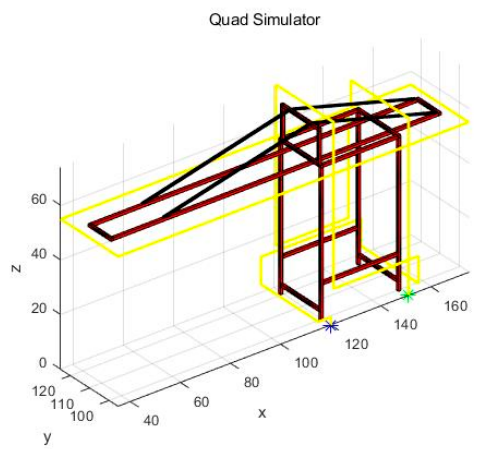
Figure 3. Simulation model of the quay crane and detection route.